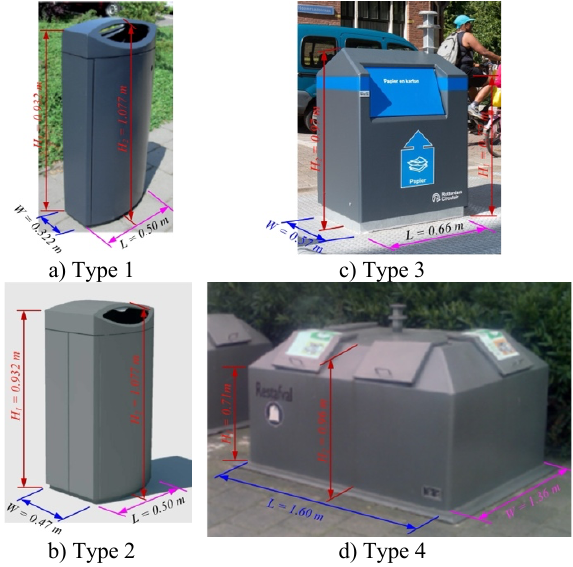
Figure 1 . Public garbage bins used in Rotterdam city,